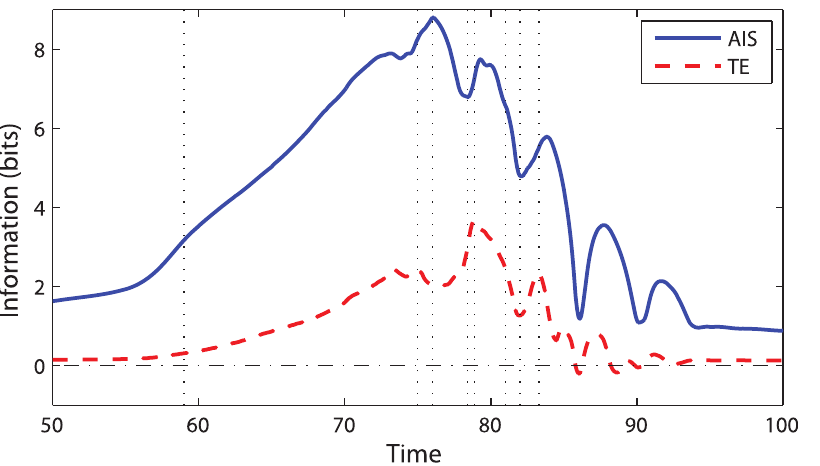
Figure 3. Information storage and transfer over time for a swarm initially consists of three squares in a checker configuration. Shown here are the average active information storage (AIS) per particle and average transfer entropy (TE) per particle